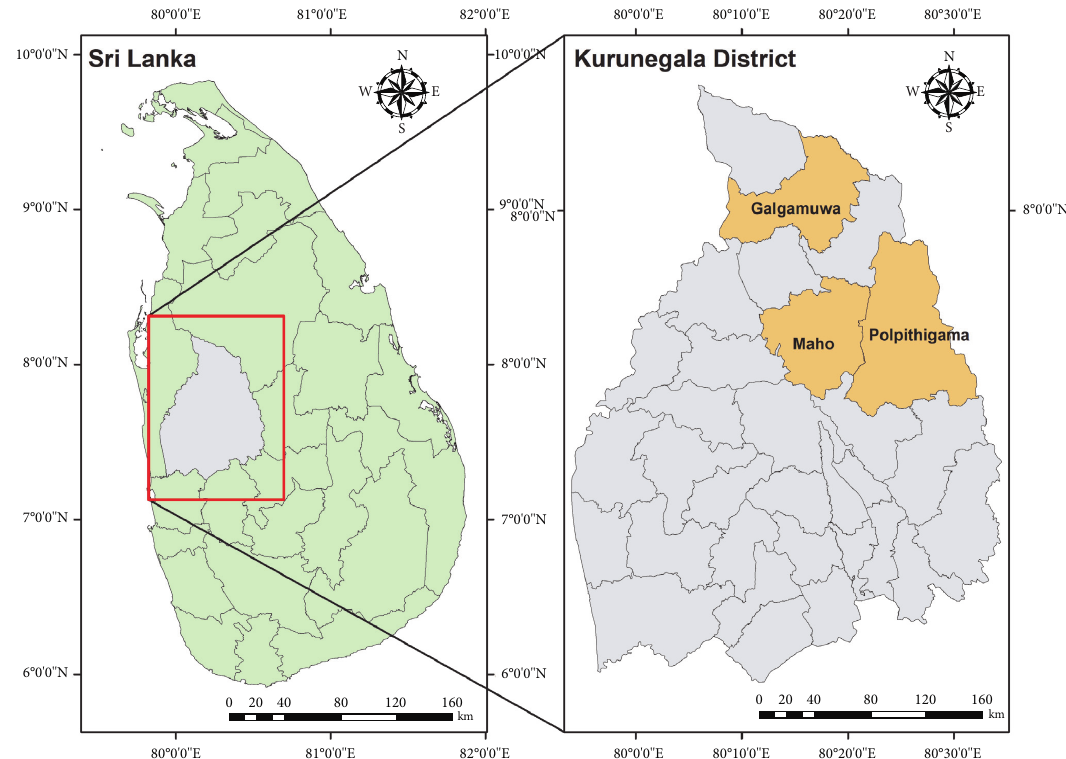
Figure 1: The locations of the study areas in Kurunegala